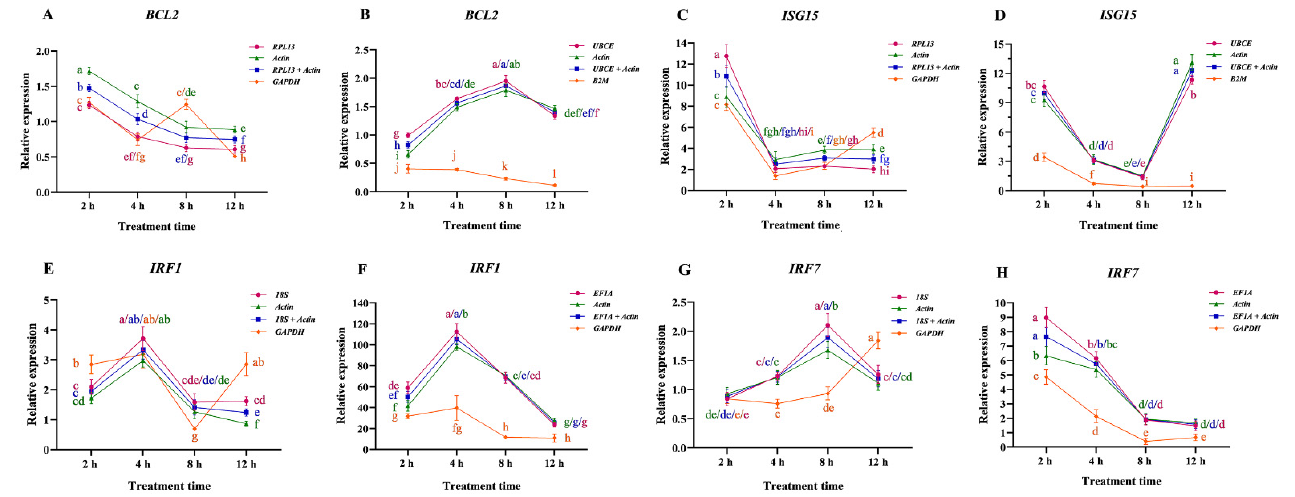
Figure 11. Expression profile for target genes in GPS and GPHK cells under stimulation with LPS or Poly I:C by virtue of screened reference genes. ( A , C ) show the relative expression levels of BCL2 and ISG15 in GPS cells after being stimulated with LPS. ( B , D ) show the relative expression levels of BCL2 and ISG15 in GPS cells after being stimulated with Poly I:C. Relative expression levels of IRF1 and IRF7 in GPHK cells after being stimulated with LPS were shown in ( E , G ), respectively. Relative expression levels of IRF1 and IRF7 in GPHK cells after being stimulated with Poly I:C were shown in ( F , H ), respectively. The bars represent standard error ( n = 3). Different letters manifest statistically significant differences in each condition ( p < 0.05).